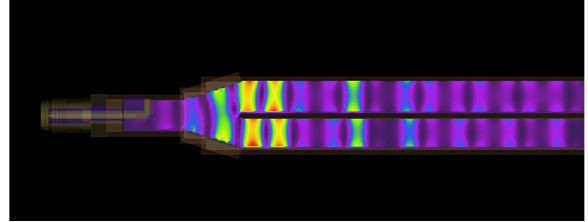
FIG. 18. FDTD simulation of dual WR51 waveguide modes arriving into a 2 ∶ 1 E-plane combiner.